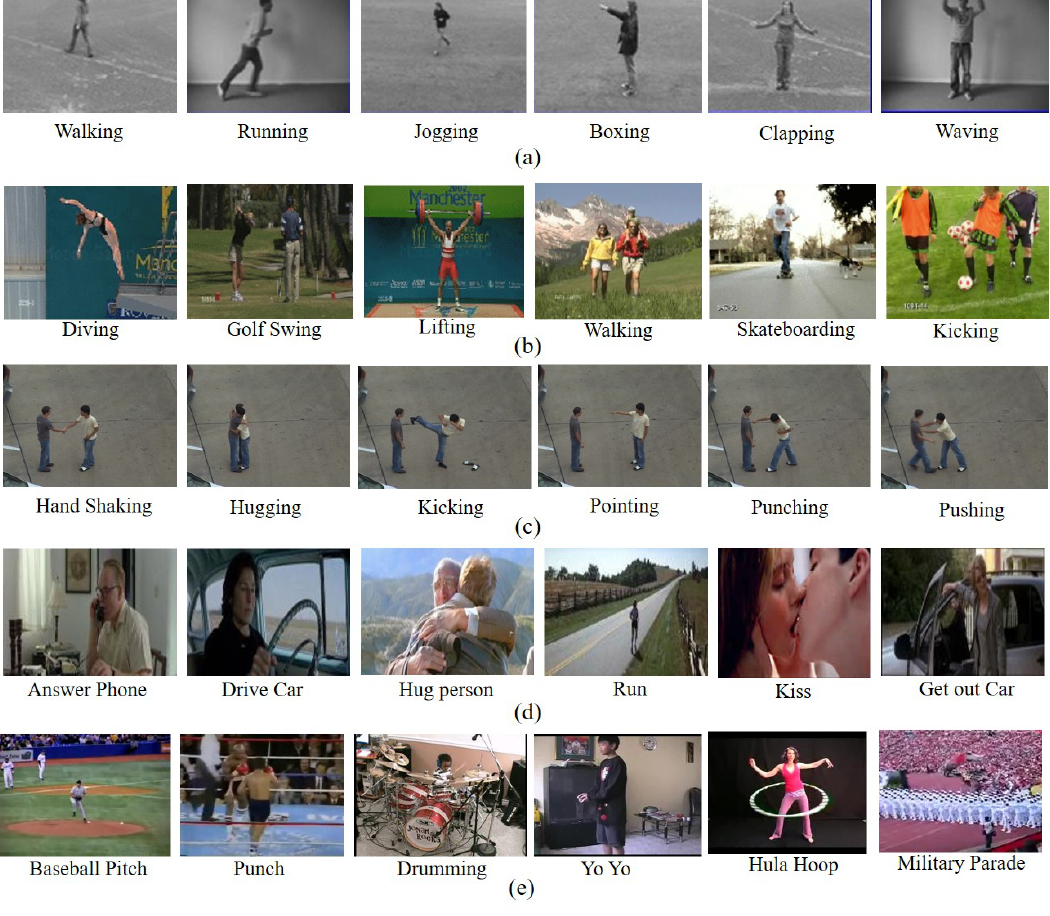
Figure 7. ( a ) Sample frames of the KTH dataset; ( b ) Sample frames of the UCF Sports action dataset; ( c ) Sample frames of the UT-Interaction dataset; ( d ) Sample frames of the Hollywood2 dataset, and ( e ) Sample frames of the UCF-101